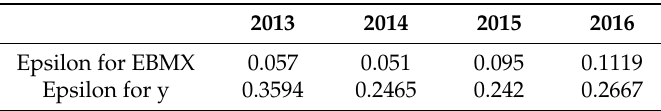
Table 3. Epsilon Scores from